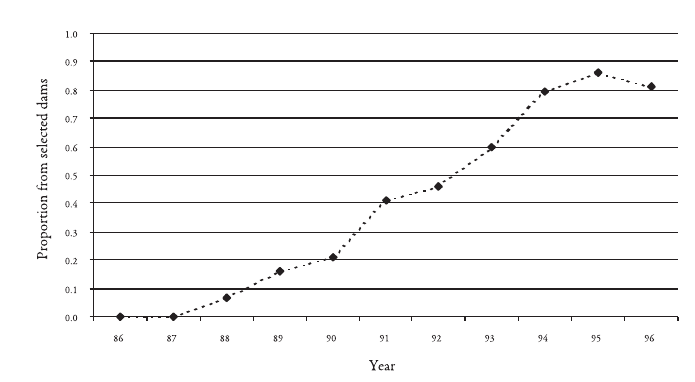
Proportion of selected female calves having mothers that were selected on weight as calves from 1986 to 1996.